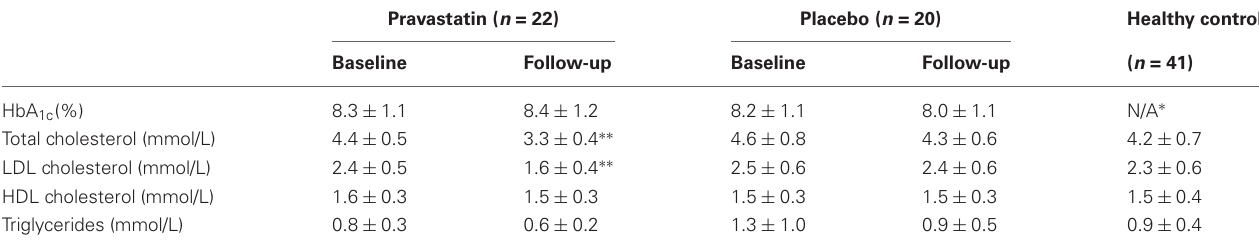
Table 2 | Glycemic control and lipid profile of the study subjects before and after treatment, and healthy control subjects.